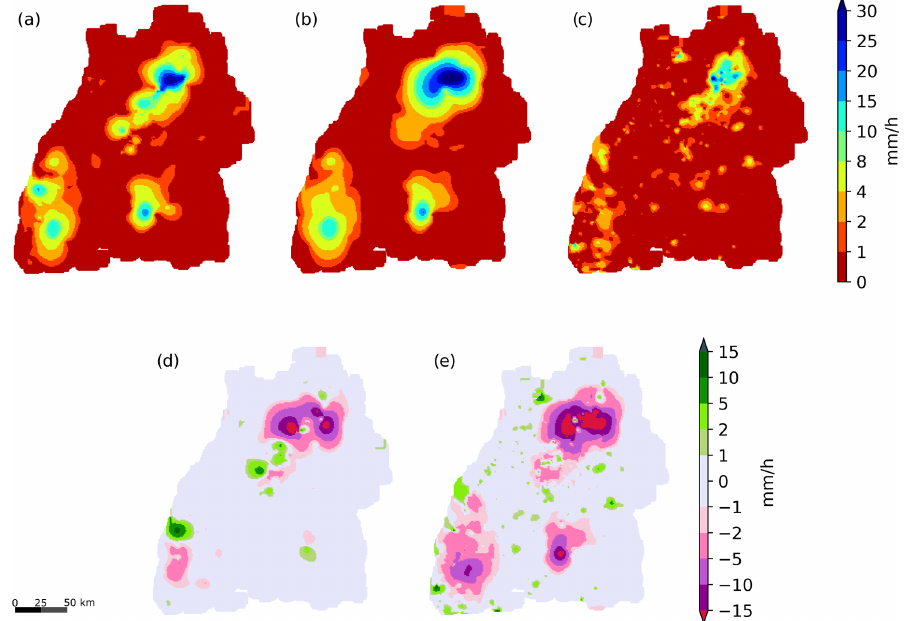
Figure 11. Interpolated precipitation for the time period from 17:00 to 18:00LT on 6 September 2018 (a–c) and the differences between primary and combination and primary and secondary data-based interpolations. Panel (a) shows the result after applying the filtering, (b) the interpolation from the primary network and (c) the one from the secondary network. Panels (d) and (e) depict the differences between (a) and (b) and (c) and (b) , respectively.